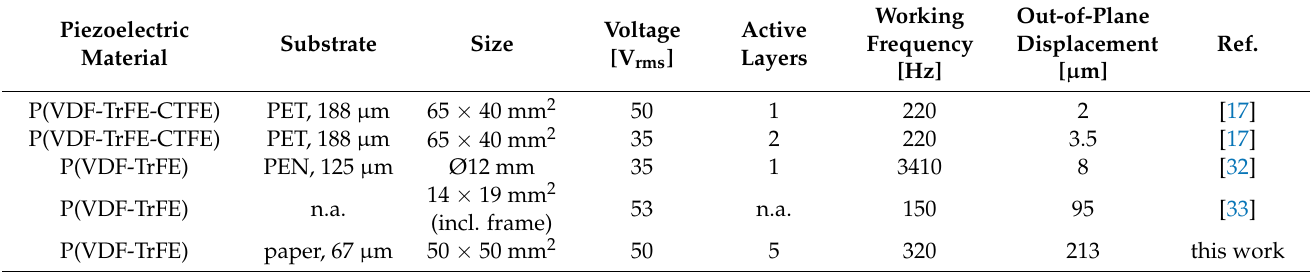
Table 2. Comparison of different flexible polymer based piezoelectric actuators used for haptic